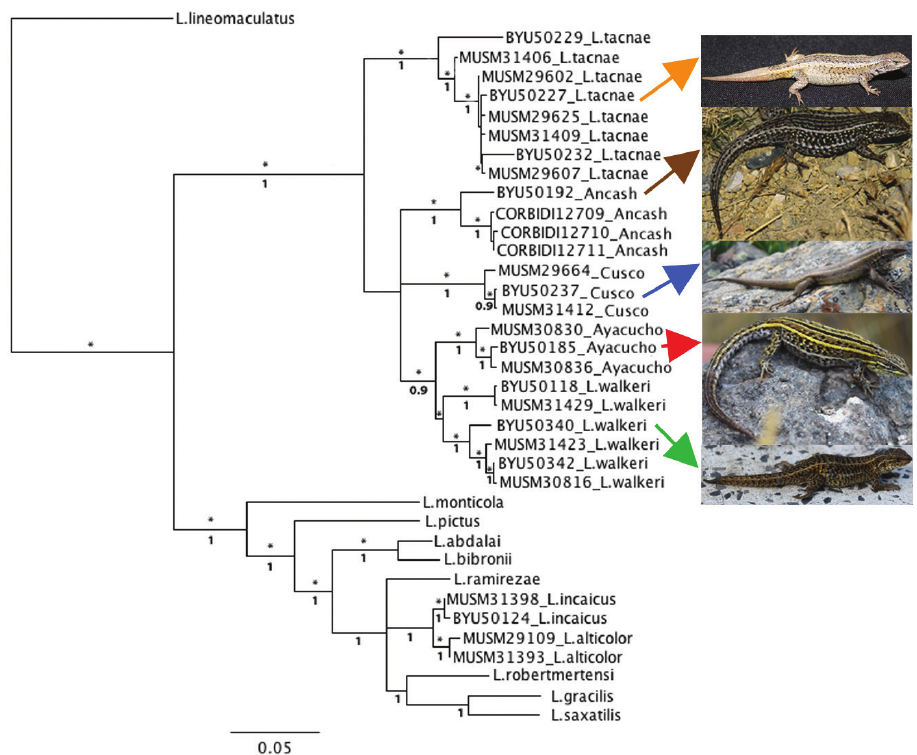
Figure 1. Concatenated maximum likelihood (-Log L = 8452.31415) tree based on cyt-b and 12S hap- lotypes of focal taxa (Ancash, Ayacucho Cusco) and species assigned to the alticolor group and outgroups. Bootstrap ≥ 70 (*) and posterior probabilities values are shown above and below branches